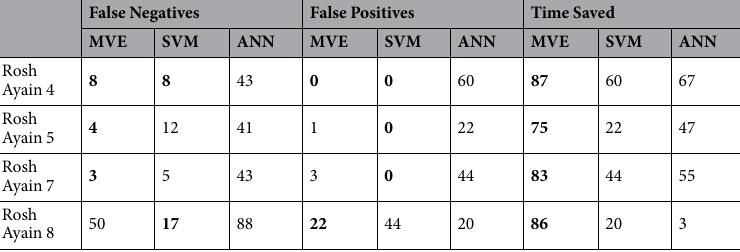
Table 5. MVE SVM and ANN Results. Percentage of False Negatives, False Positives and Time saved on average, i.e., how many days in advance on average an alarm was raised before the actual outburst.